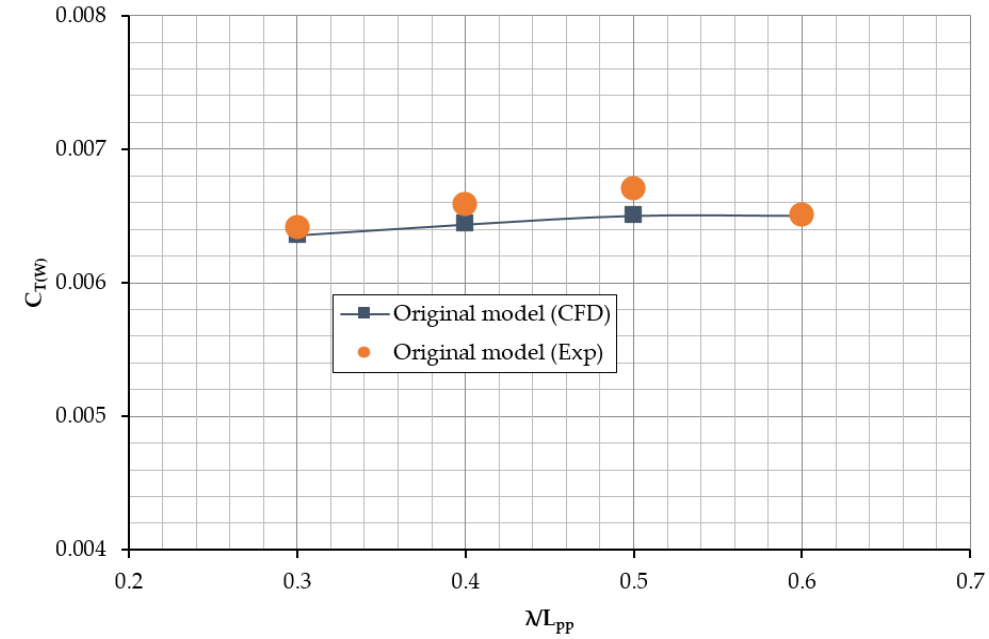
Figure 5. Validation of CFD results of the total resistance coefficients of the ship in regular head and short waves, H w = 0.02 m, F n = 0.163.